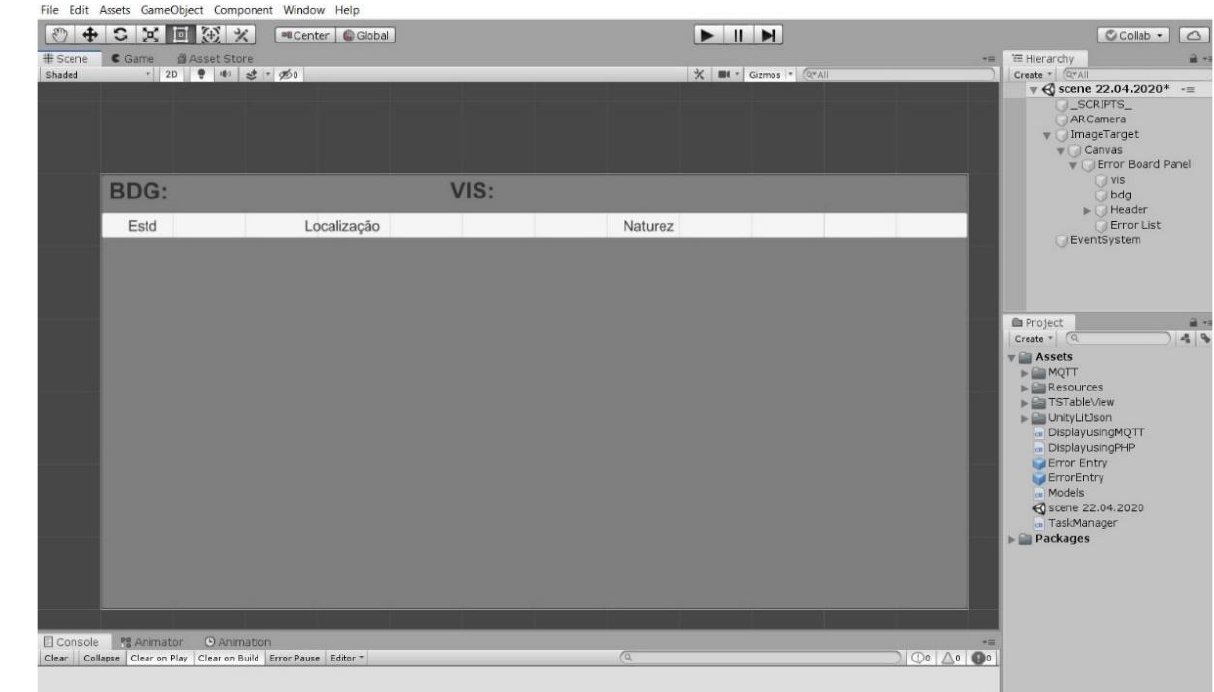
Figure 5. A screenshot of our development environment (Unity), presenting the UI design where BDG/VIS, Estd, Localização, and Naturez represent respectively: Vehicle ID, defect type (Control/er- ror), defect location in the vehicle, and defect description.